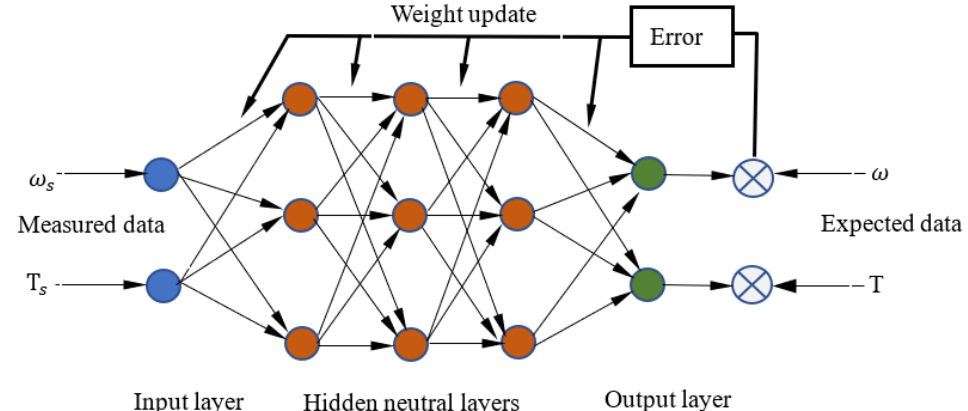
Figure 10. Structure of the neural network adopted for thermal calibration. Seventy percent of the data were randomly selected for the training. The actual